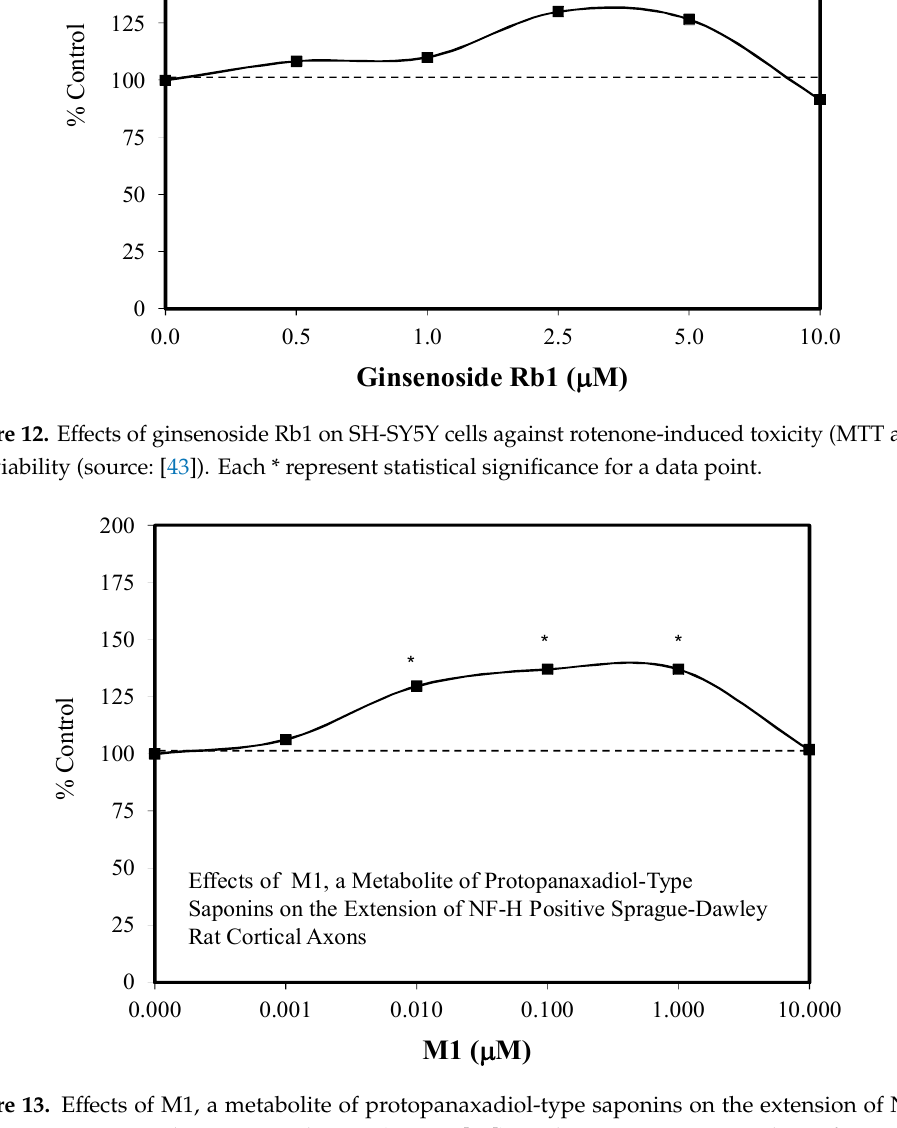
Figure 13. Effects of M1, a metabolite of protopanaxadiol-type saponins on the extension of NF-H positive Sprague–Dawley rat cortical axons (source: [67]). Each * represent statistical significance for a data point.